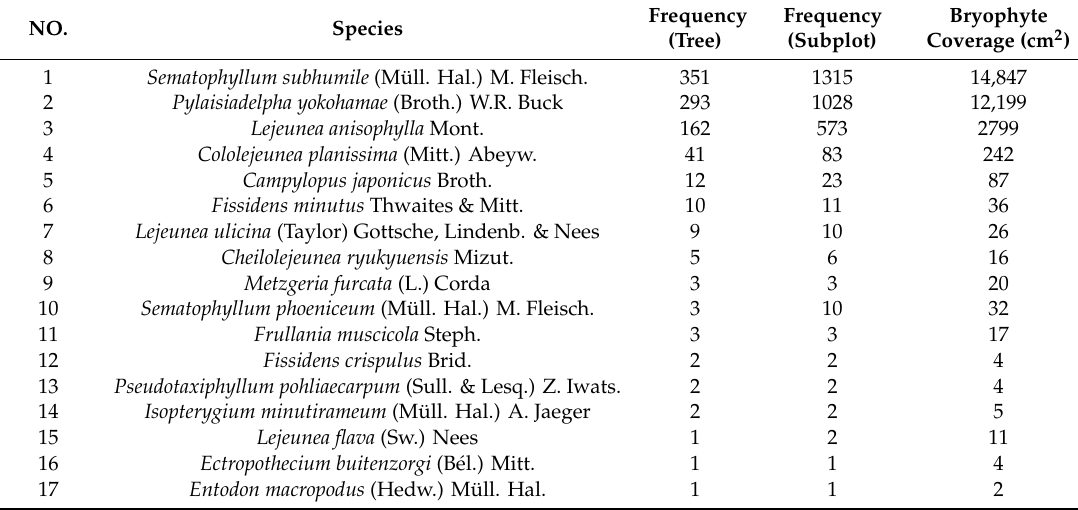
Table A2. The results of VIF before and after screening variables. Before screening variables